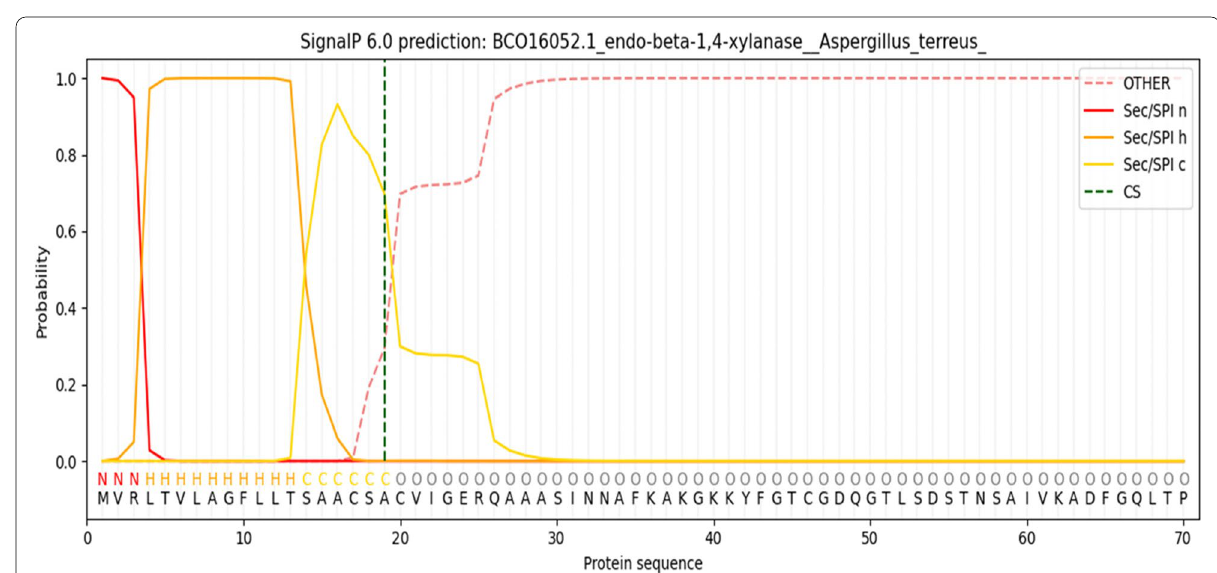
Fig. 18 Signal IP prediction of amino acids for xylanase gene from A. terreus strain RGS. Eg‑NRC (xyl) gene and other xylanase